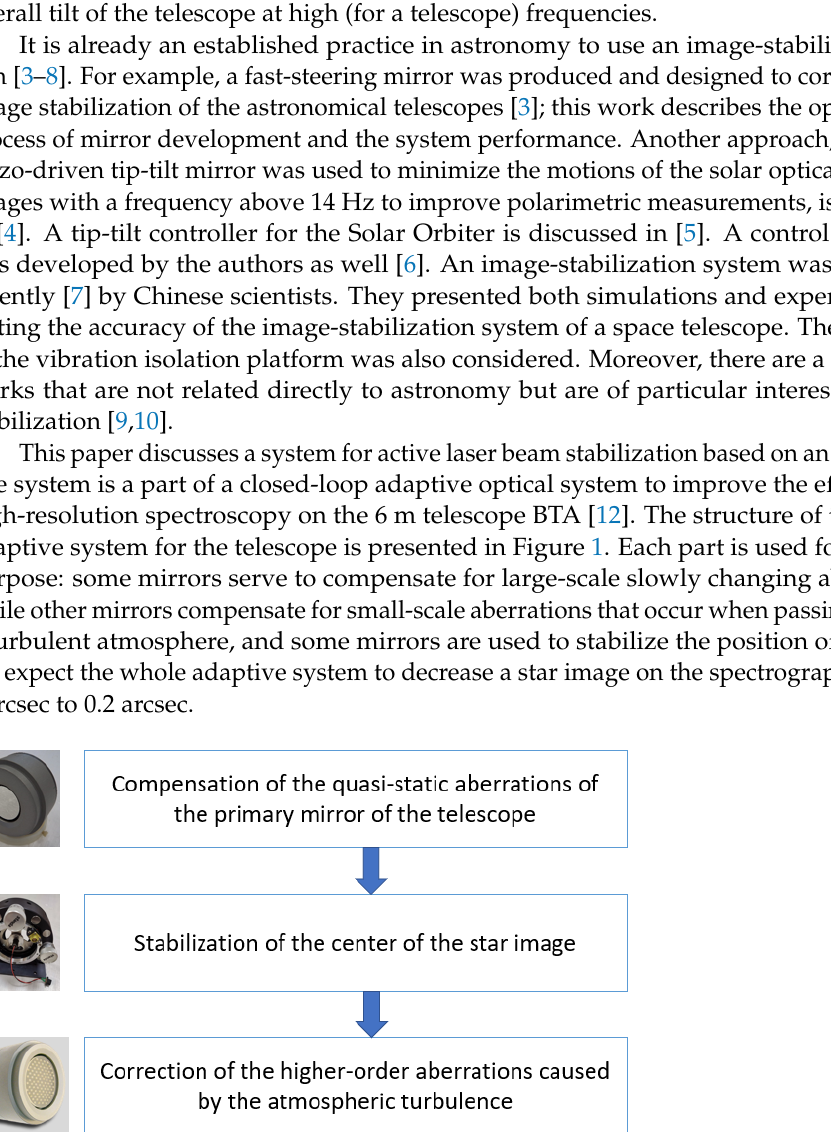
Figure 1. A cascade of adaptive systems to increase the efficiency of high-resolution spectroscopy.